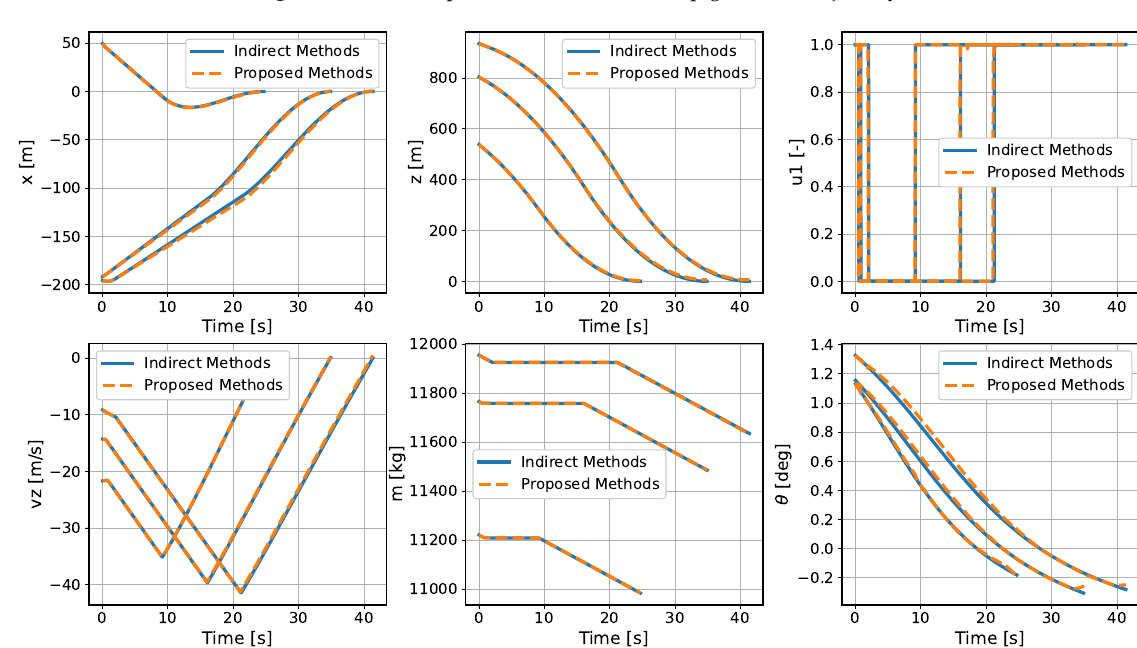
Figure 11. The comparison of the closed-loop guidance trajectory for HVR.